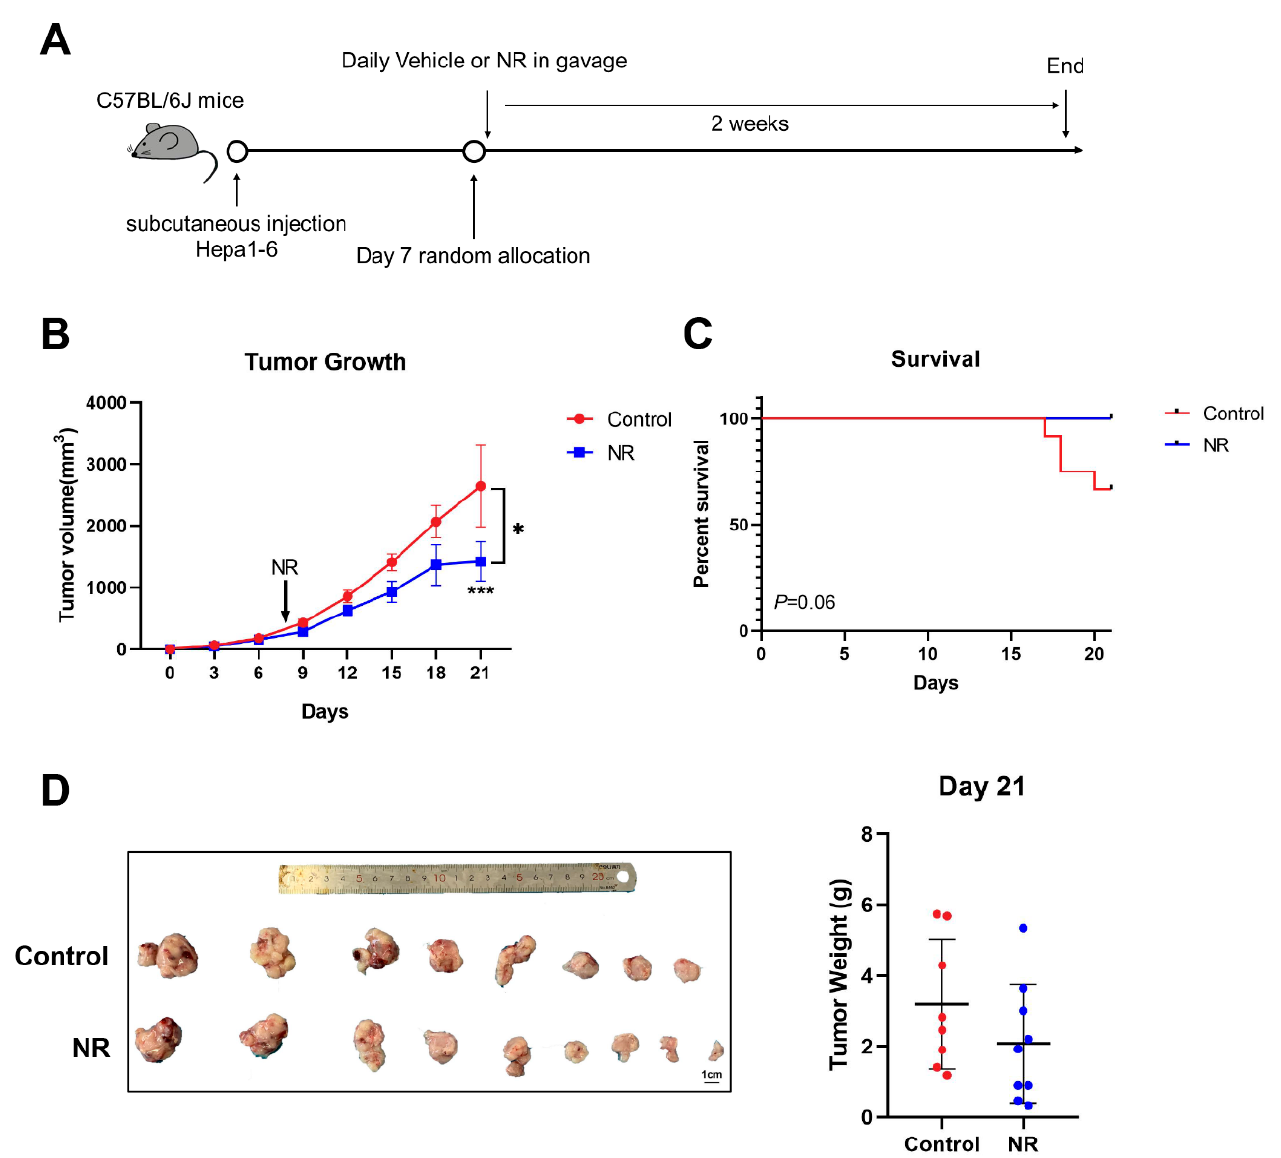
Figure 5. NR inhibited in situ tumor growth in C57BL/6J mice. ( A ) Schematic of the subcutaneous allograft model. ( B ) Subcutaneous tumor growth curves of mice during the experiment. ( C ) Survival percentage of mice in the experiment. ( D ) Tumor weight of mice after two weeks of treatment. n = 9–12/group; Red dots: control mice; blue dots: NR-treated mice. * p < 0.05 compared to the control group, *** p < 0.001 compared to the control group. p -values were calculated using mixed-effects model (REML) and Sidak’s multiple comparisons test ( B ), Log-rank (Mantel-Cox) test ( C ), and unpaired t test ( D ). NR, nicotinamide riboside.